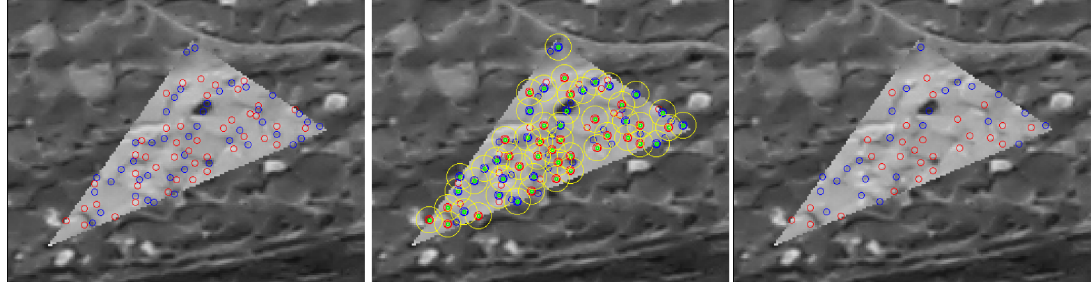
Figure 11. An illustration of the interest point reduction. ( Left ): original points. ( Center ): filter area (yellow). ( Right ): filter result.